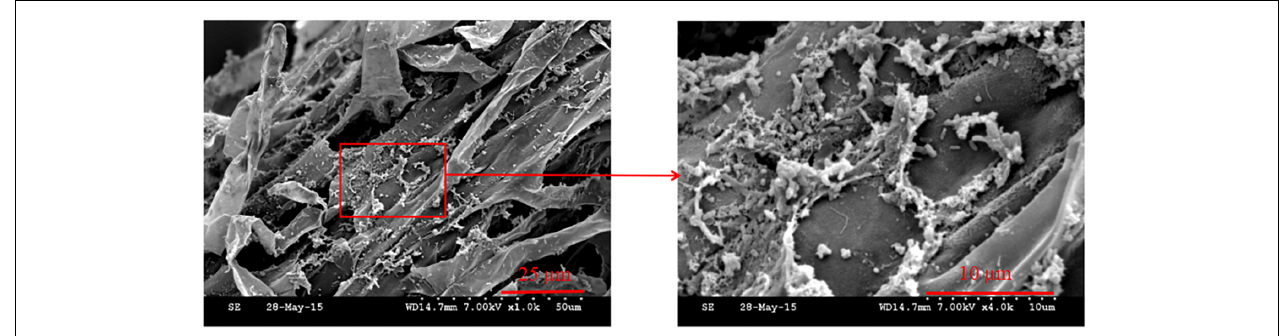
FIGURE 3 | The colonization of strain Phe15 on the root surface of white clover observed by scanning electron microscope (WD14.7 mm 7.00 kV). The magnification of the left and right image is 1.0 and 4.0 k,